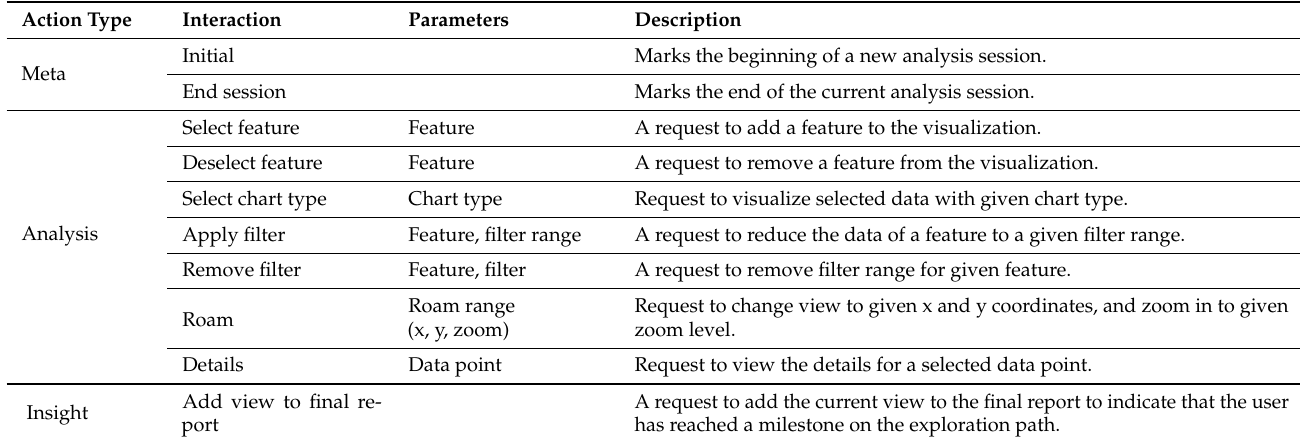
Table 1. Set of interactions to be recorded by the interaction storage of our prototype